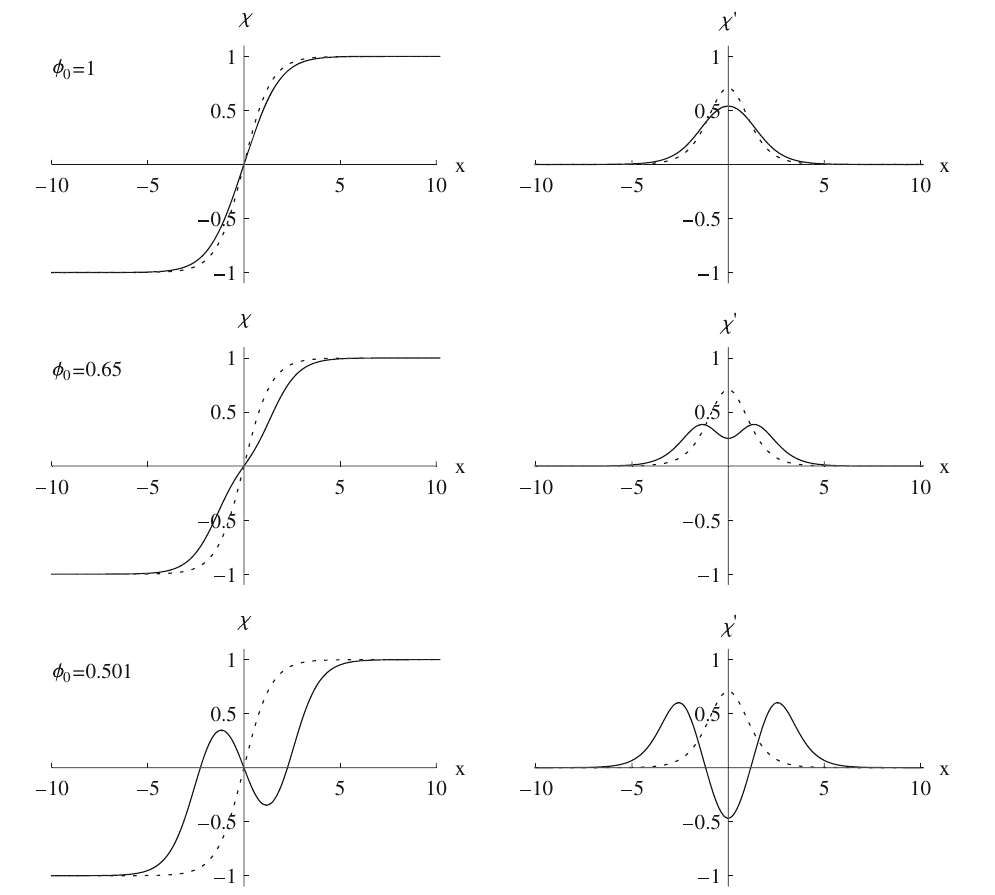
Fig. 6 The bosonic field and its derivative with respect to x corresponding to positive bound energy for φ 0 = 1, φ 0 = 0 . 65 and φ 0 = 0 . 501. Solid and dashed curves depict the bosonic field and its derivative in the dynamical and background models, respectively